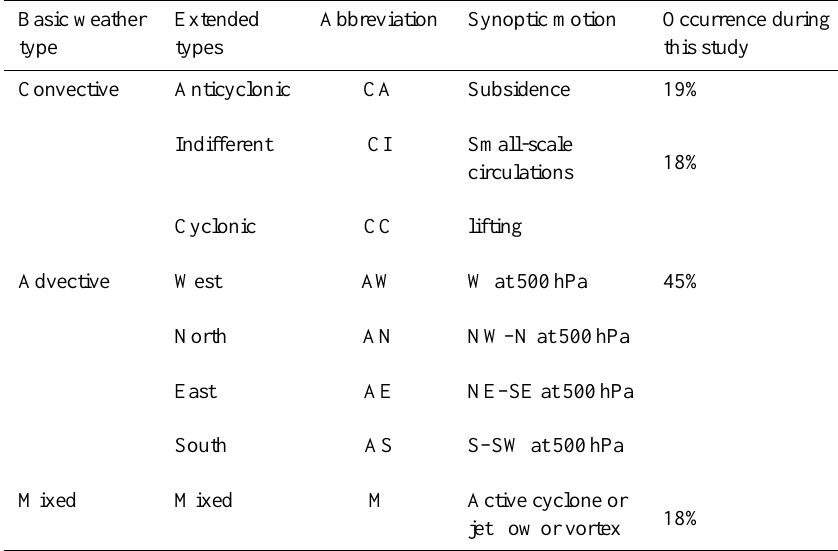
Table 1. The 3 basic and 8 extended types of the Alpine weather statistics and their dominant synoptic scale